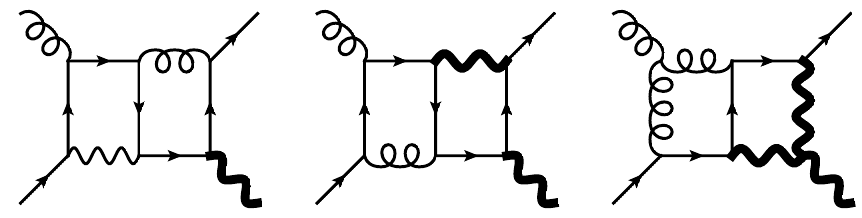
Figure 2 . The di(cid:11)erent top-sector Feynman integrals, in terms of the distribution of the external massive leg.